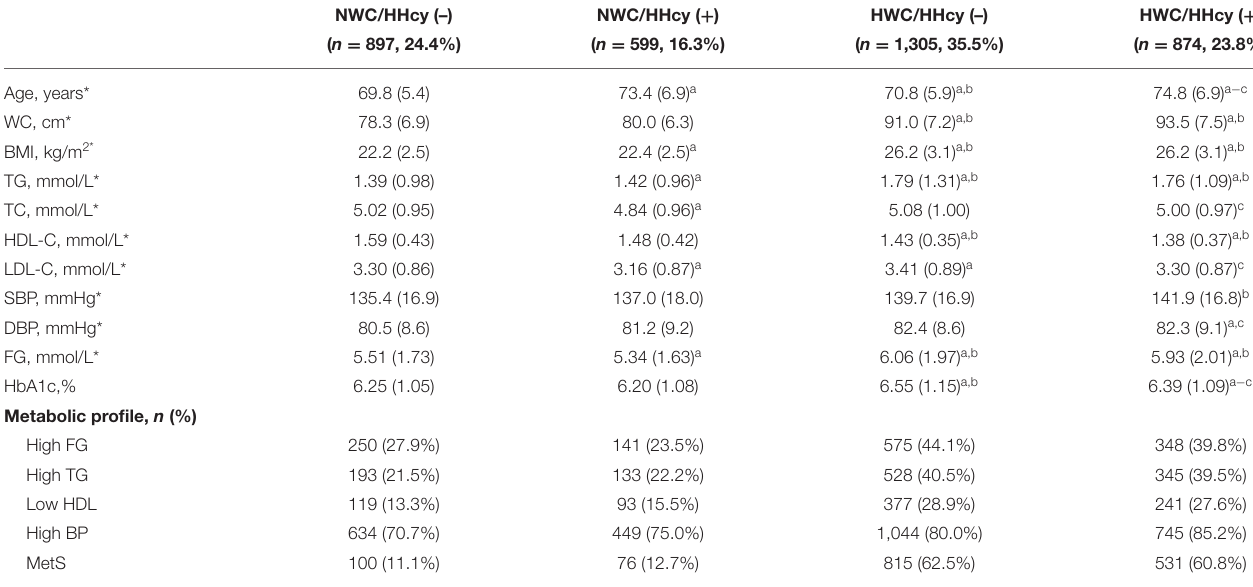
TABLE 2 | Metabolic profile of the study group categorized by WC and Hcy. NWC/HHcy